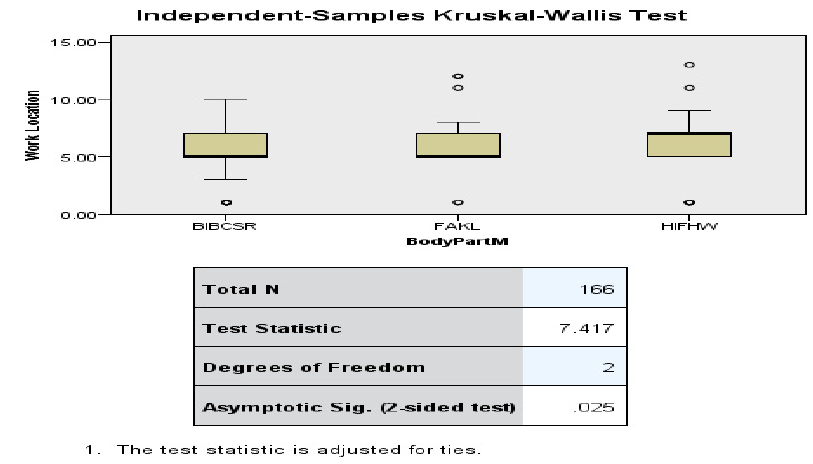
Figure 3. Independent samples Kruskal–Wallis test for H 02 . Source: own elaboration.